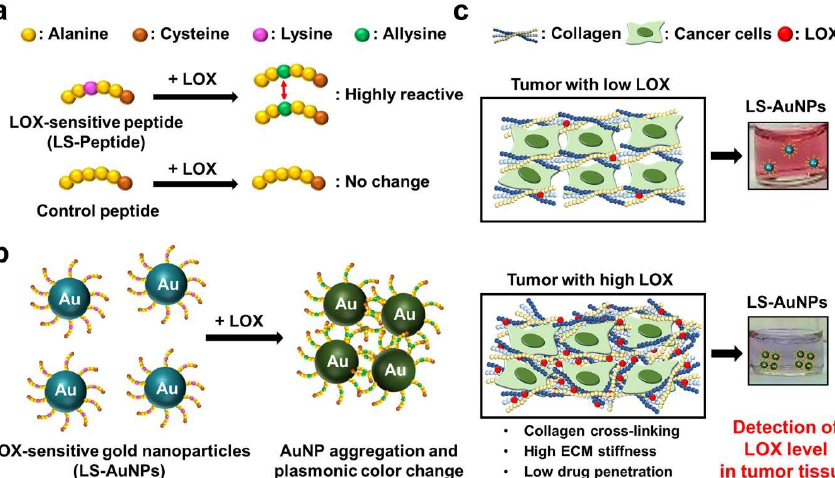
Figure 1. ( a ) The reaction between the lysyl oxidase (LOX)-sensitive hexapeptides containing lysine (LS-peptides) or hexapeptides without lysine (control peptides) and LOX. The addition of LOX caused lysine to convert to highly reactive allysine. ( b ) A schematic showing the principles of the colorimetric assay for LOX detection using LS-AuNPs. Due to the interactions between the highly reactive allysines, LS-AuNPs aggregate, thereby yielding a plasmonic color change. ( c ) The color of the AuNP suspension turns from the original pinkish red colour to blue/purple due to the aggregation of LS-AuNPs induced by the high LOX level in the tumor microenvironment.